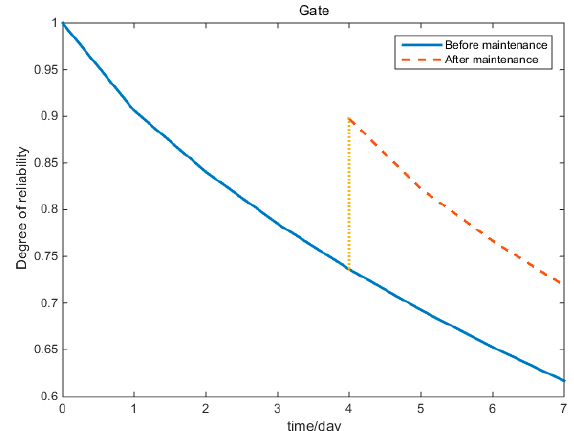
Figure 16. The reliability change due to the maintenance of gates.